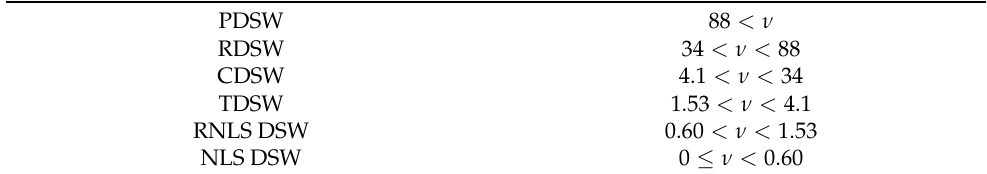
Table 1. Regime boundaries for type classifications of Figure 2. Here, u − = 1.0, u + = 0.8 and q = 2. PDSW 88 < ν RDSW 34 < ν < 88 CDSW 4.1 < ν < 34 TDSW 1.53 < ν < 4.1 RNLS DSW 0.60 < ν < 1.53 NLS DSW 0 ≤ ν <